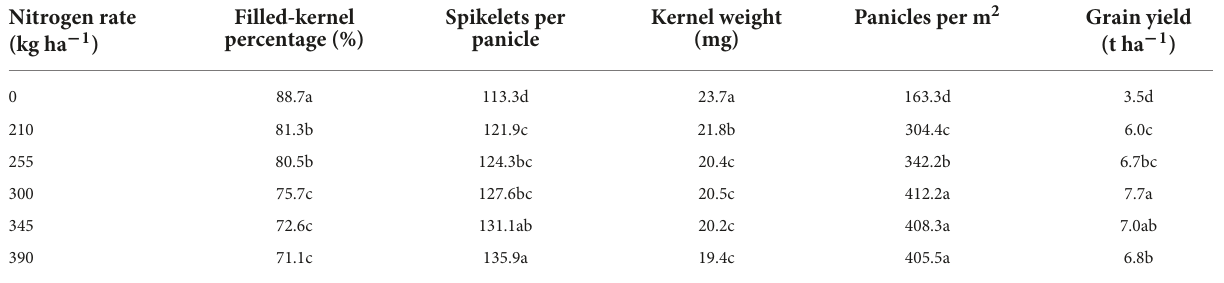
TABLE 1 Effects of different nitrogen rates on rice yield and yield components in saline-alkaline field. Nitrogen rate